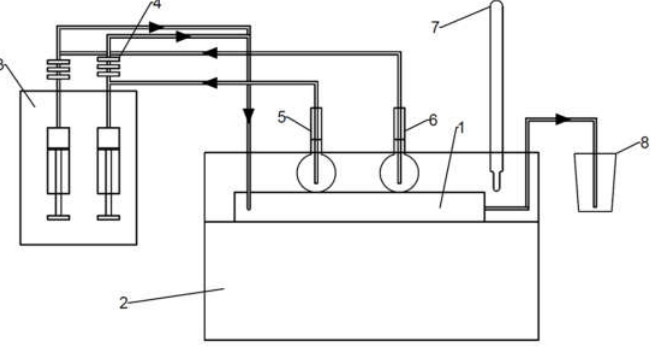
Figure 3. The system used for the synthesis of MoS 2 (1—impinging jet reactor, 2—thermostat, 3—syringe pump, 4—filter set, 5—flask with HMA-CA, 6—flask with AS, 7—thermometer, 8—product container).